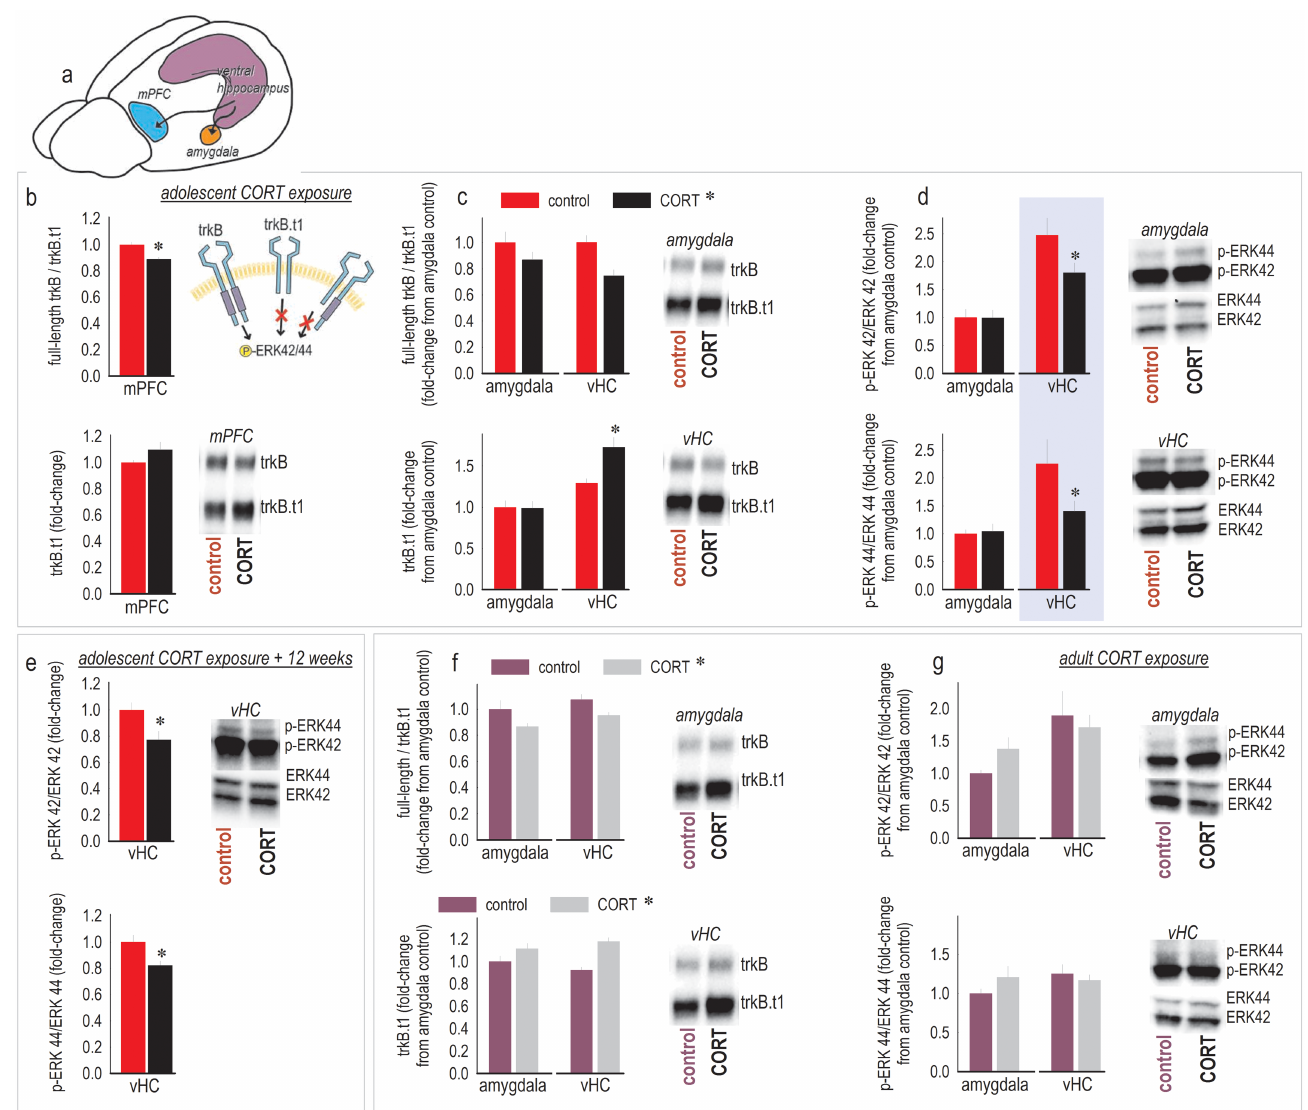
Fig 3. Adolescent CORT exposure regulates cortico-limbic trkB and ERK42/44phosphorylation. (a) Based on our findings,we profiledthe neurobiological effects of CORT in a mPFC–vHC–amygdala circuit. (b) Brains were first collectedat the end of the CORT exposure period. Top : AdolescentCORT exposuredecreasedthe ratio of full-lengthto truncatedtrkB in the mPFC, which woulddecreasethe ability of full-lengthtrkB to initiate intracellularsignalingevents, illustrated at right. Bottom : trkB.t1 levels alone did not significantlydiffer. (c) Top : Adolescent CORT exposure also decreased the ratio of full-lengthto truncatedtrkB in the vHC and amygdala. Bottom : In the vHC, this was accompaniedby an increasein overall trkB.t1 levels. (d) Top : p-ERK42 levels were higheroverall in the vHC than in the amygdala,and CORT reducedvHC p-ERK42 (in